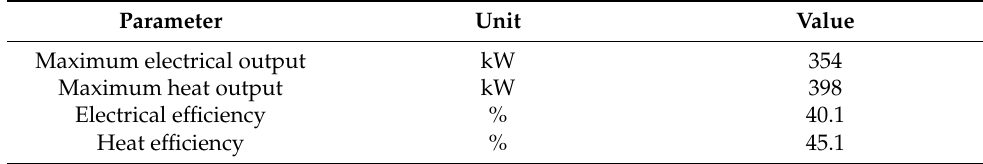
Table 2. Technical specification of Flexi 350 cogeneration